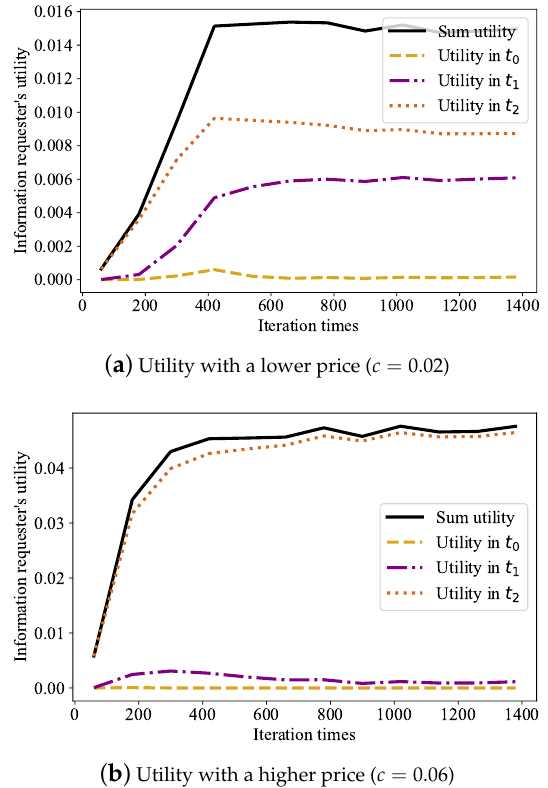
Figure 10. Sum-value utilities with different prices to crowd workers.